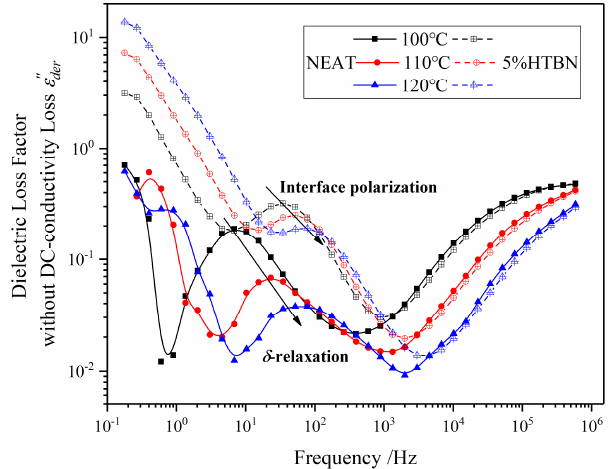
Figure 11. Frequency spectrum characteristics of dielectric loss factor without DC-conductivity loss from 100 °C to 120 °C.